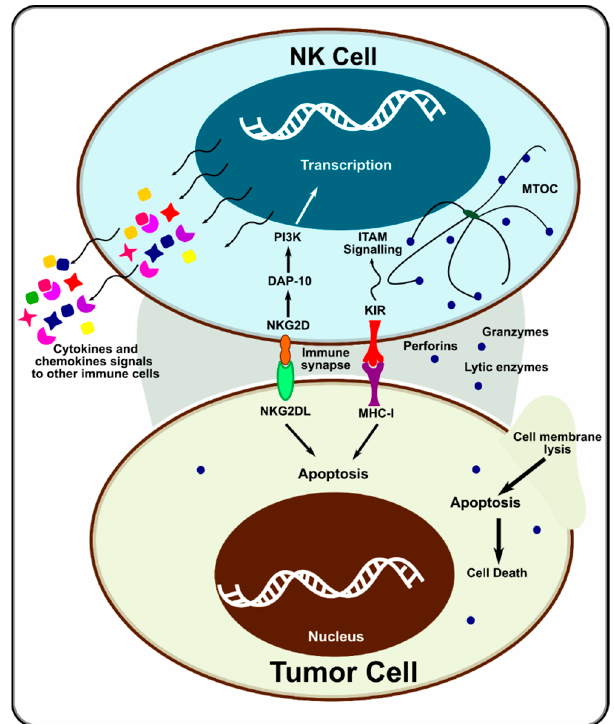
Figure 2. Mechanism of action of NK cell on tumor cells. Adapted from [68].